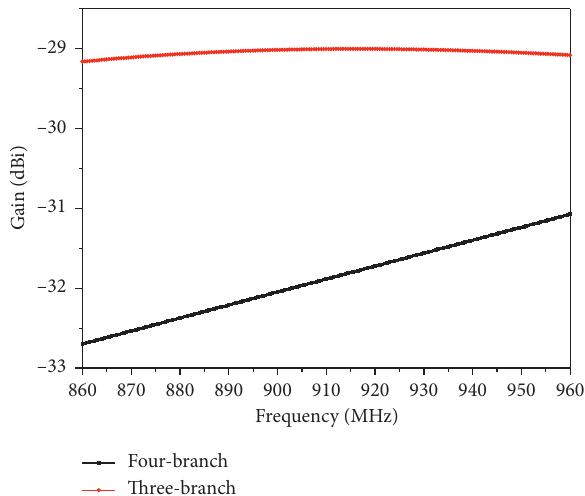
Figure 6: Simulated far-field gains of three-branch and four-branch antennas.